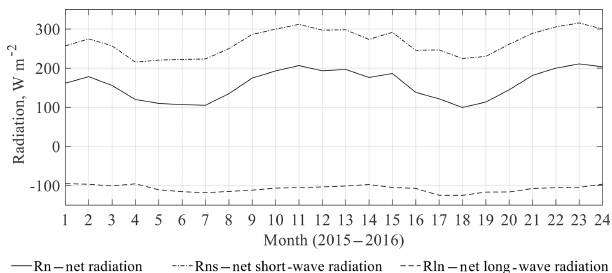
Figure 4. Monthly average radiative budget for Lake Titicaca in 2015–2016.